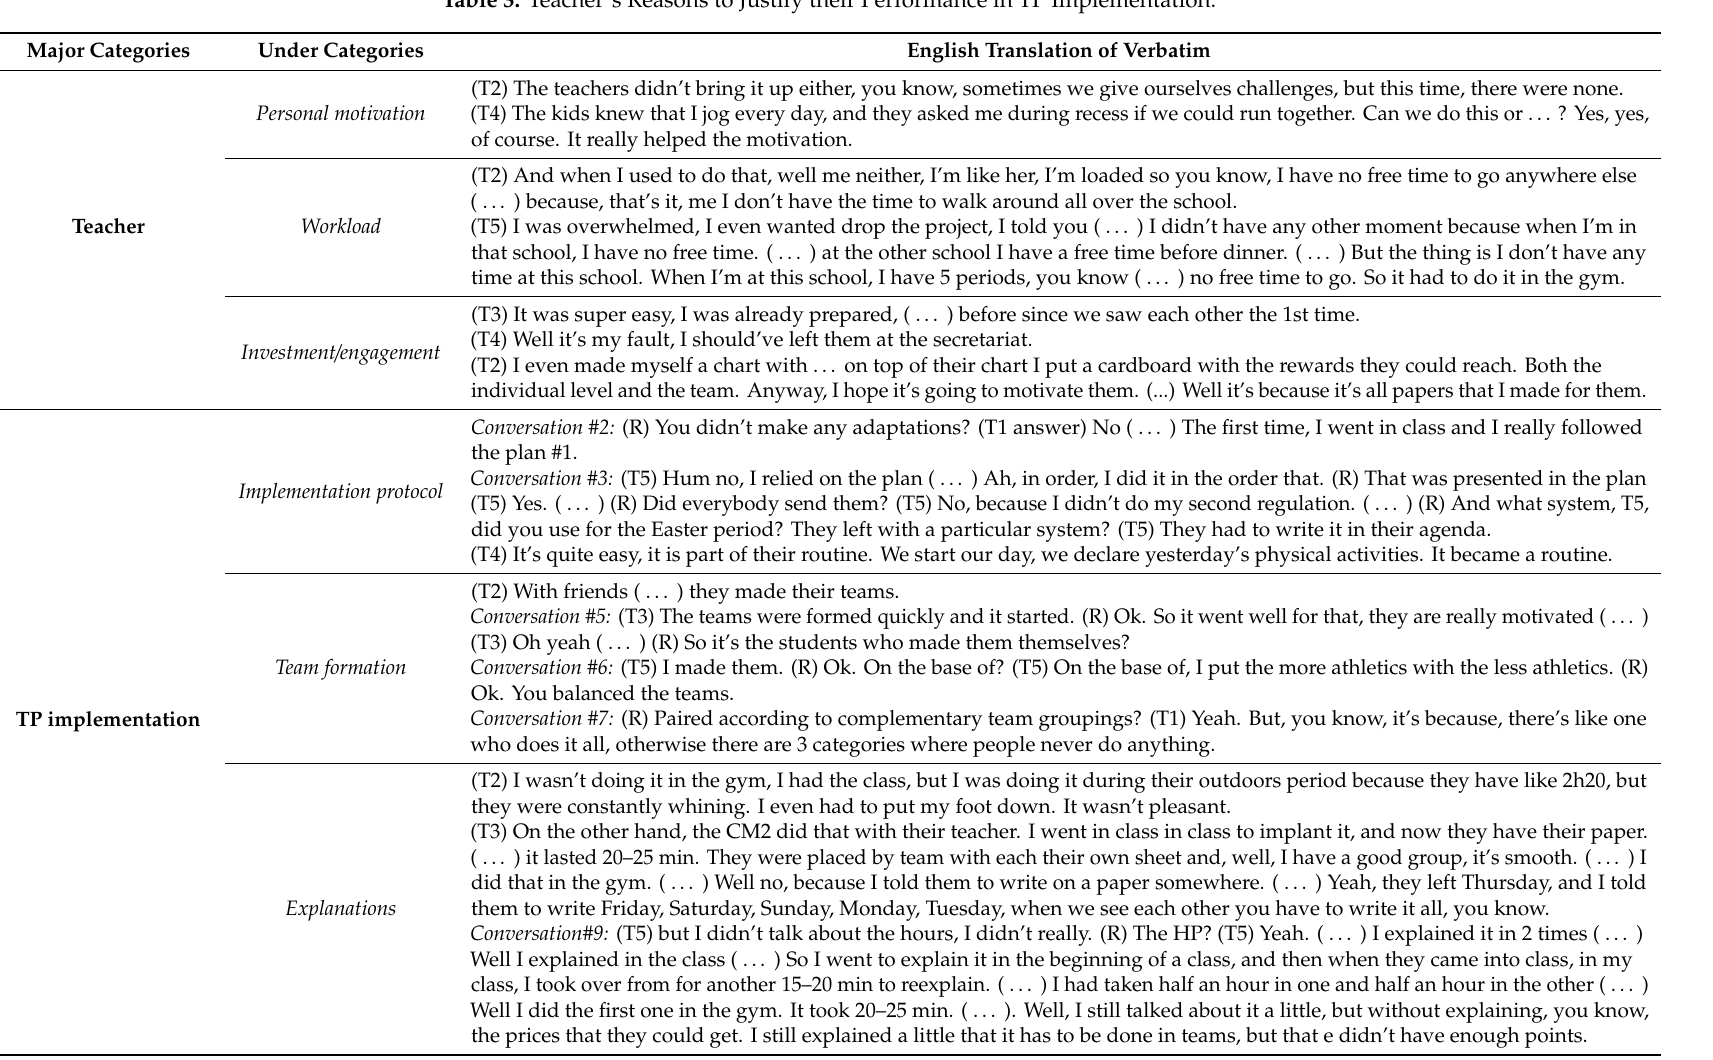
Table 3. Teacher’s Reasons to Justify their Performance in TP